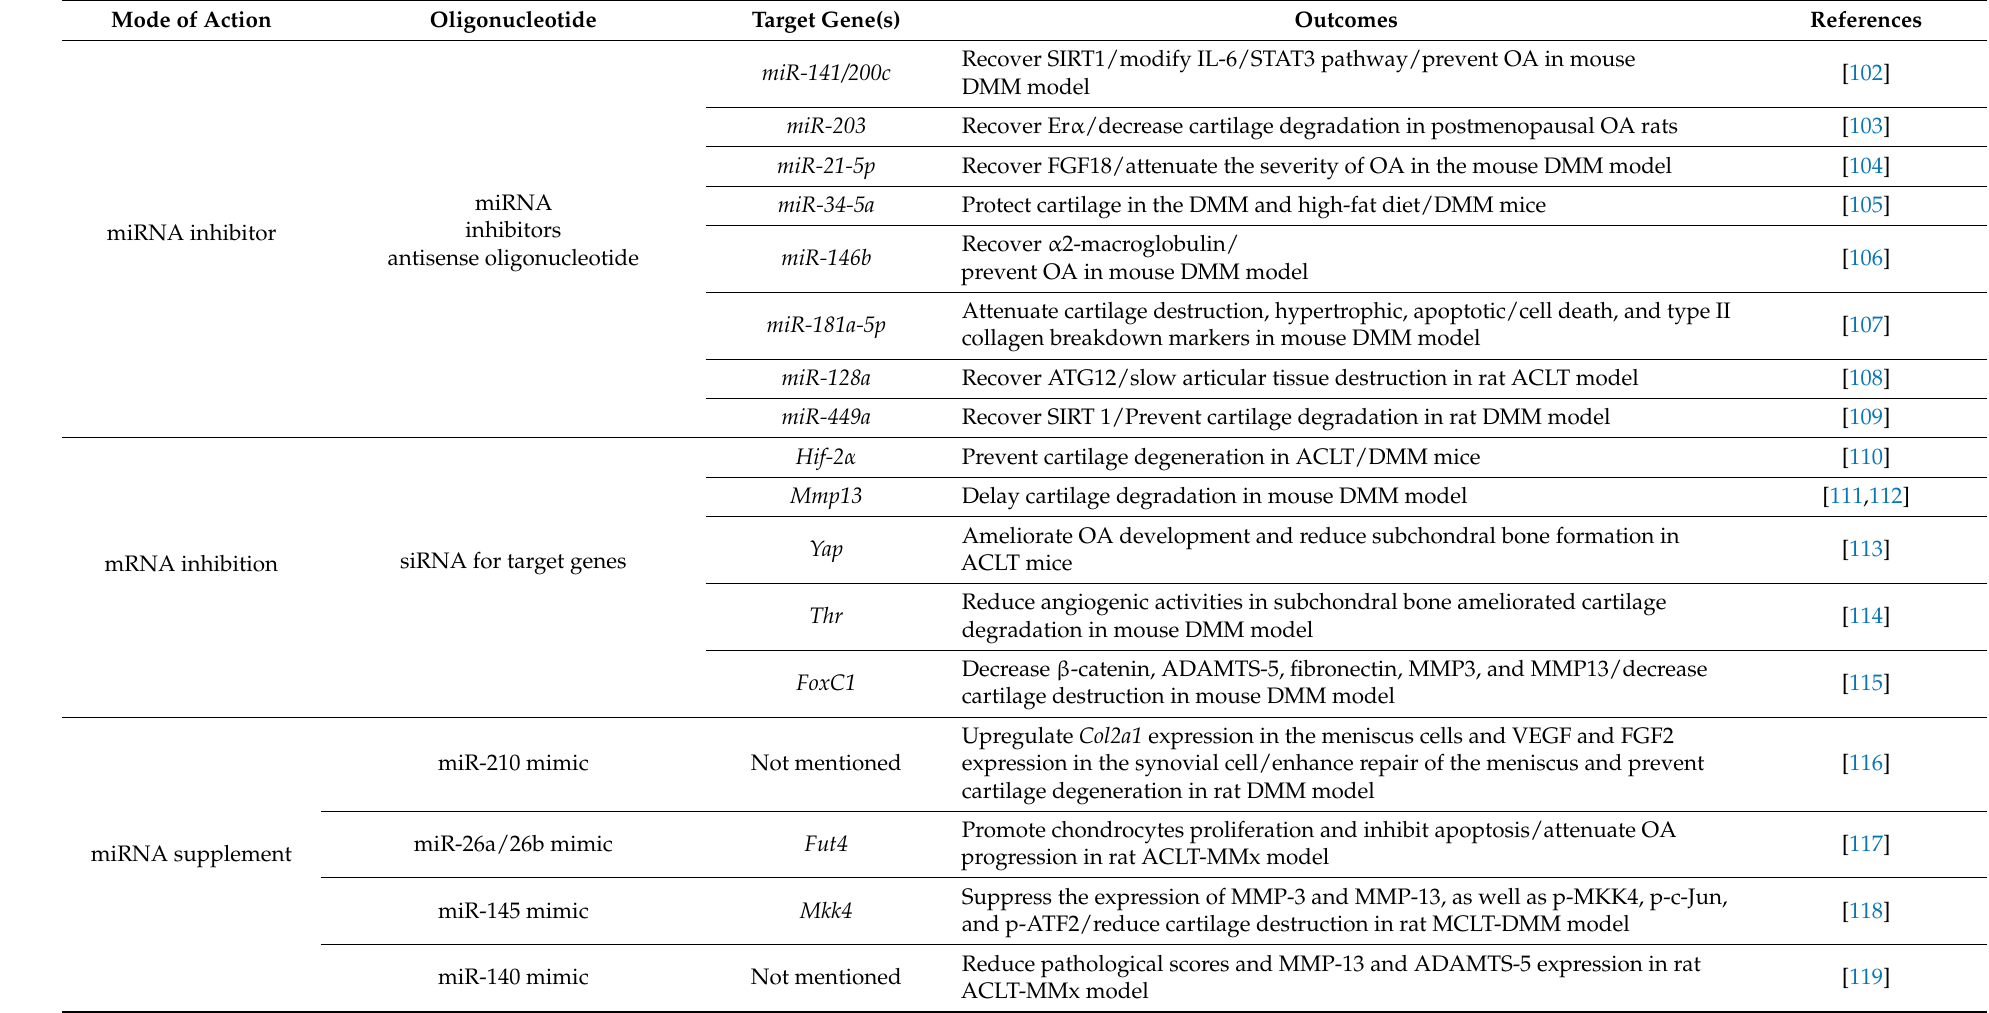
Table 4. Oligonucleotide therapeutics candidates 1 with in vivo efficacy via IA